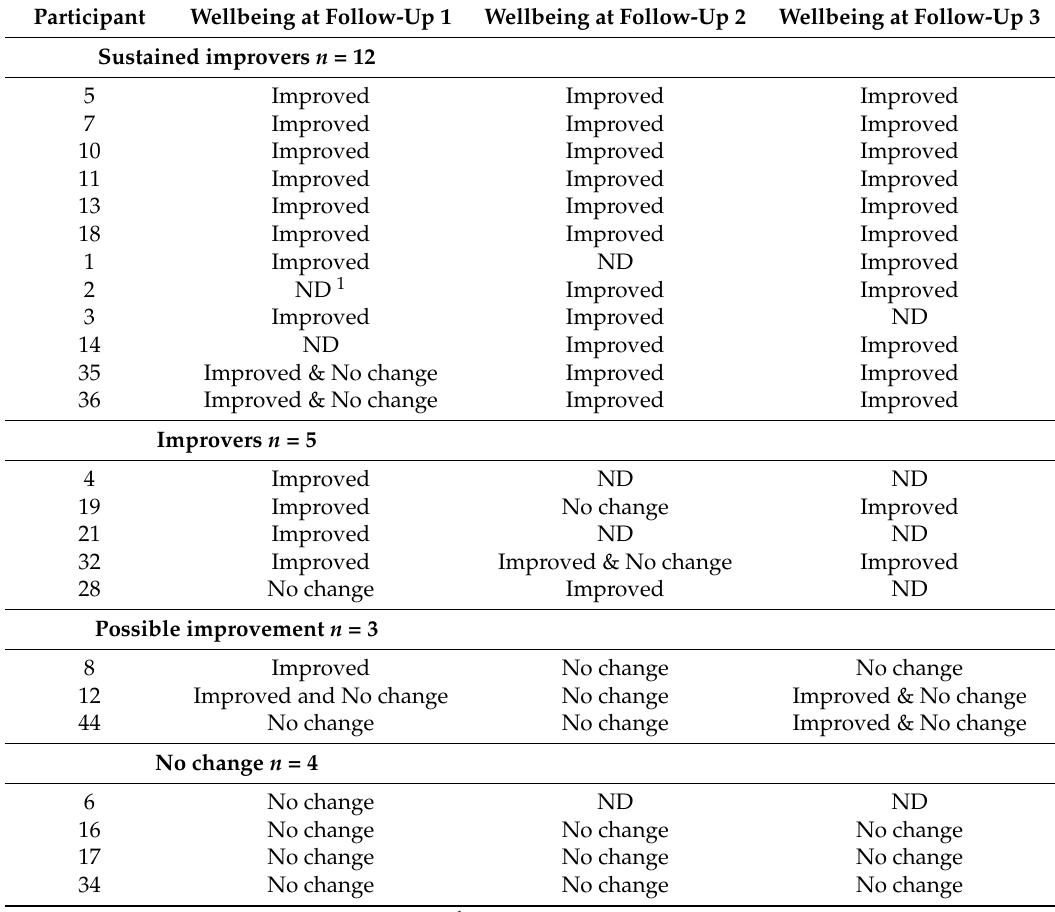
Table 7. Participants’ self-report of mental wellbeing at each